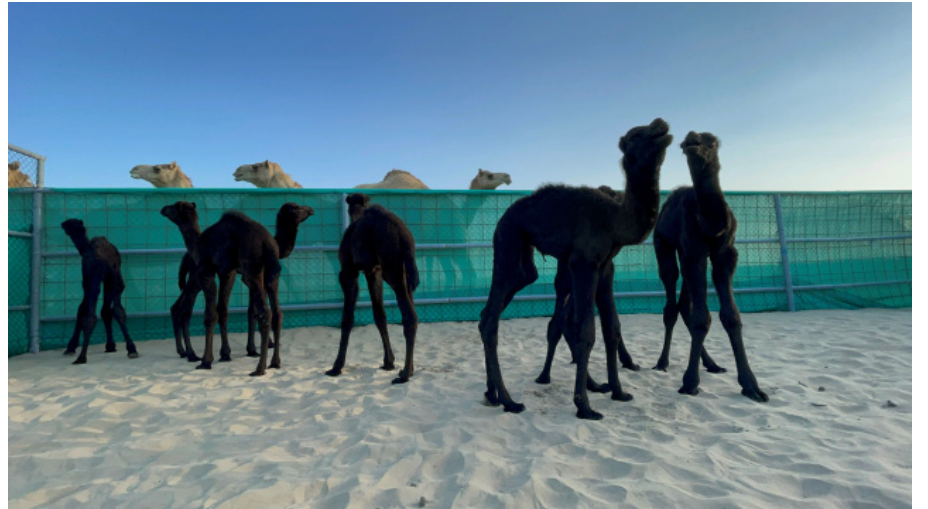
Figure 4. Representative photograph of cloned offspring.